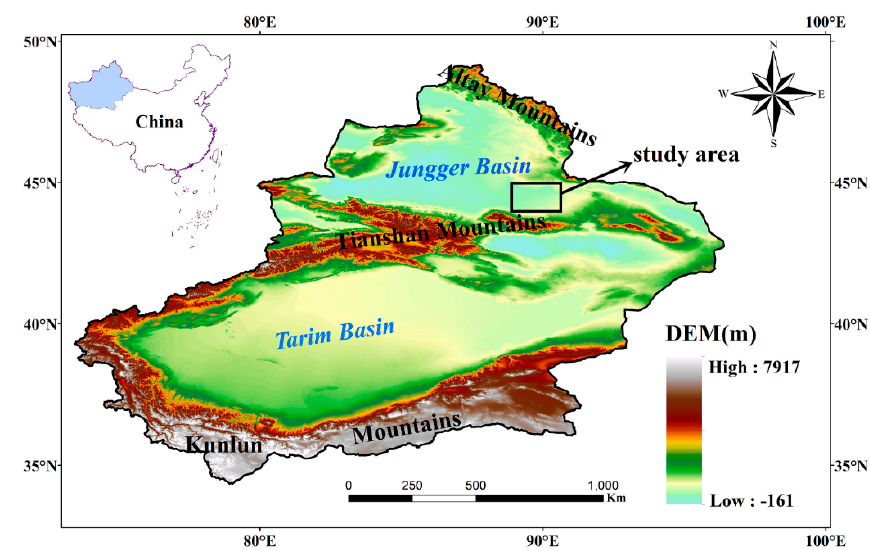
Figure 1. The geographical location of the study area.